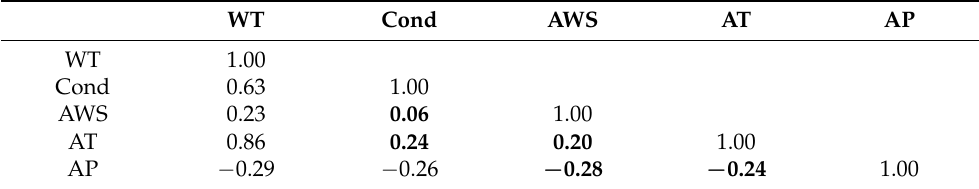
Table 6. Correlation analysis among selected variables WT, Cond, AWS, AT, and AP in sunny-day dataset, and several key correlation coefficients are shown in bold in the table.